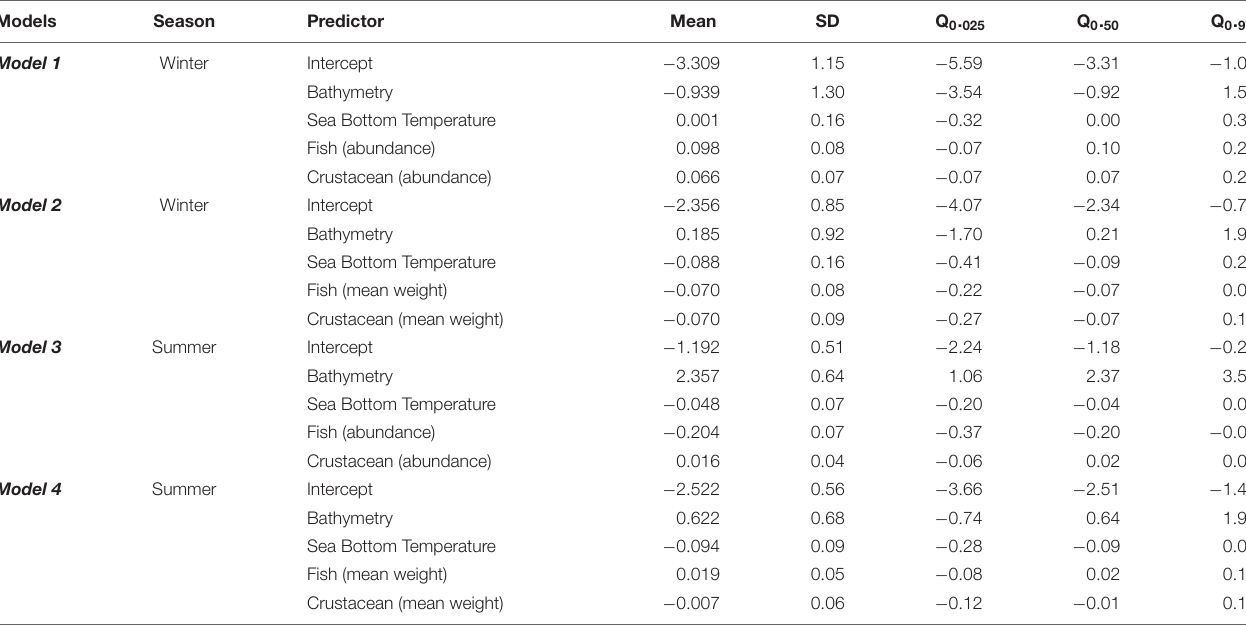
TABLE 2 | Summary of the posterior distribution for the four models ( Model 1, Model 2, Model 3, and Model 4 ).